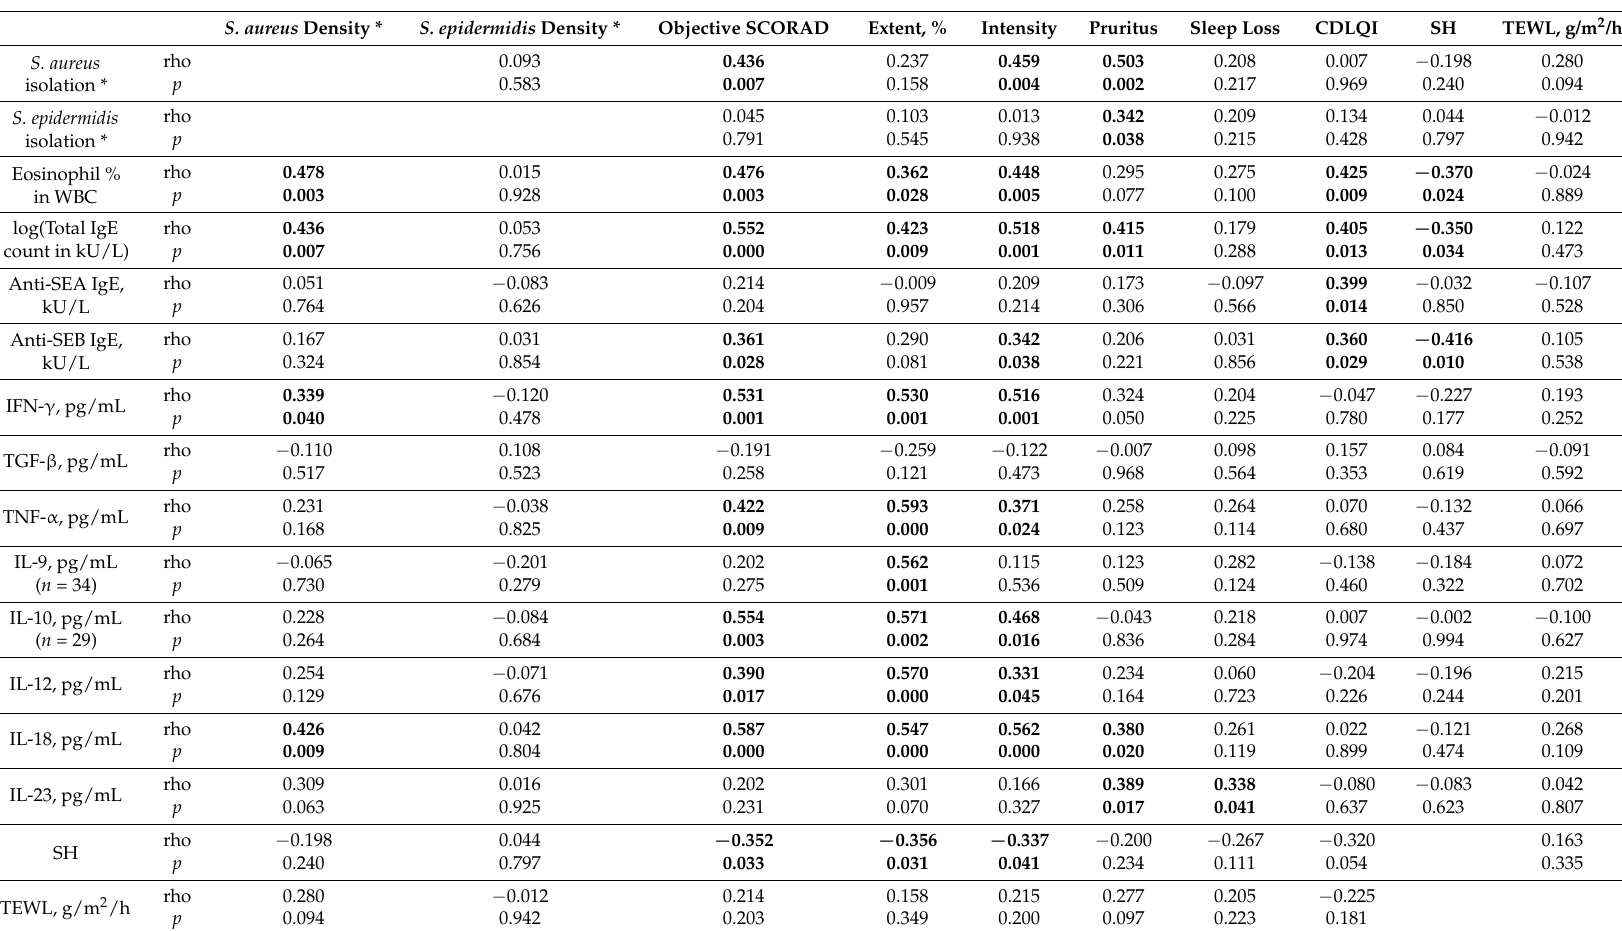
Table 3. Adjusted Spearman’s correlations between seromarkers and clinical indices ( n = 40; adjusted for age of admission, personal allergic rhinitis and personal